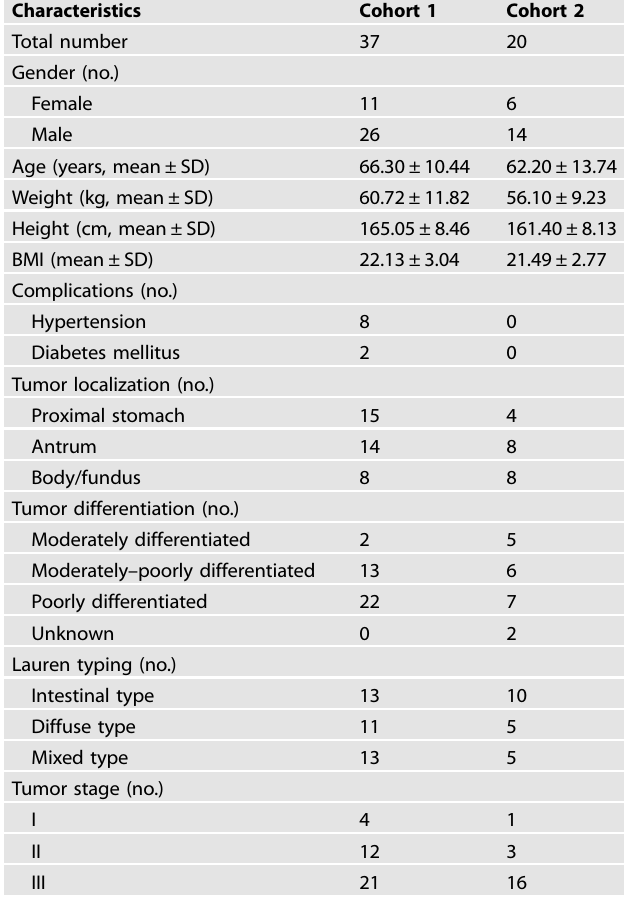
Table 1. Clinicopathological characteristics of patients with GC in this